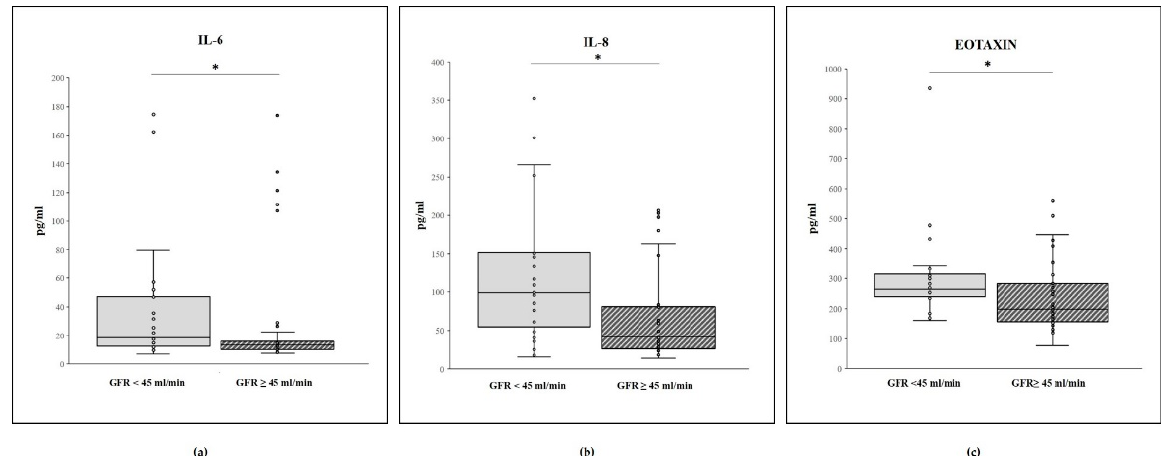
Figure 3. Box plot of plasma level (pg/mL) of ( a ) IL-6, ( b ) IL-8, and ( c ) Eotaxin in GFR <45 mL/min/1.73 m 2 ( n = 28, 37.8%) and GFR ≥ 45 mL/min/1.73 m 2 ( n = 28, 37.8%) groups. Within each box (25th–75th percentile), the horizontal black lines represent the median values; points outside the whiskers represent outliers, i.e., measurements outside the median ± 1.5 × (75th–25th percentile). p -values < 0.05 for all comparisons, according to the Mann–Whitney U test.